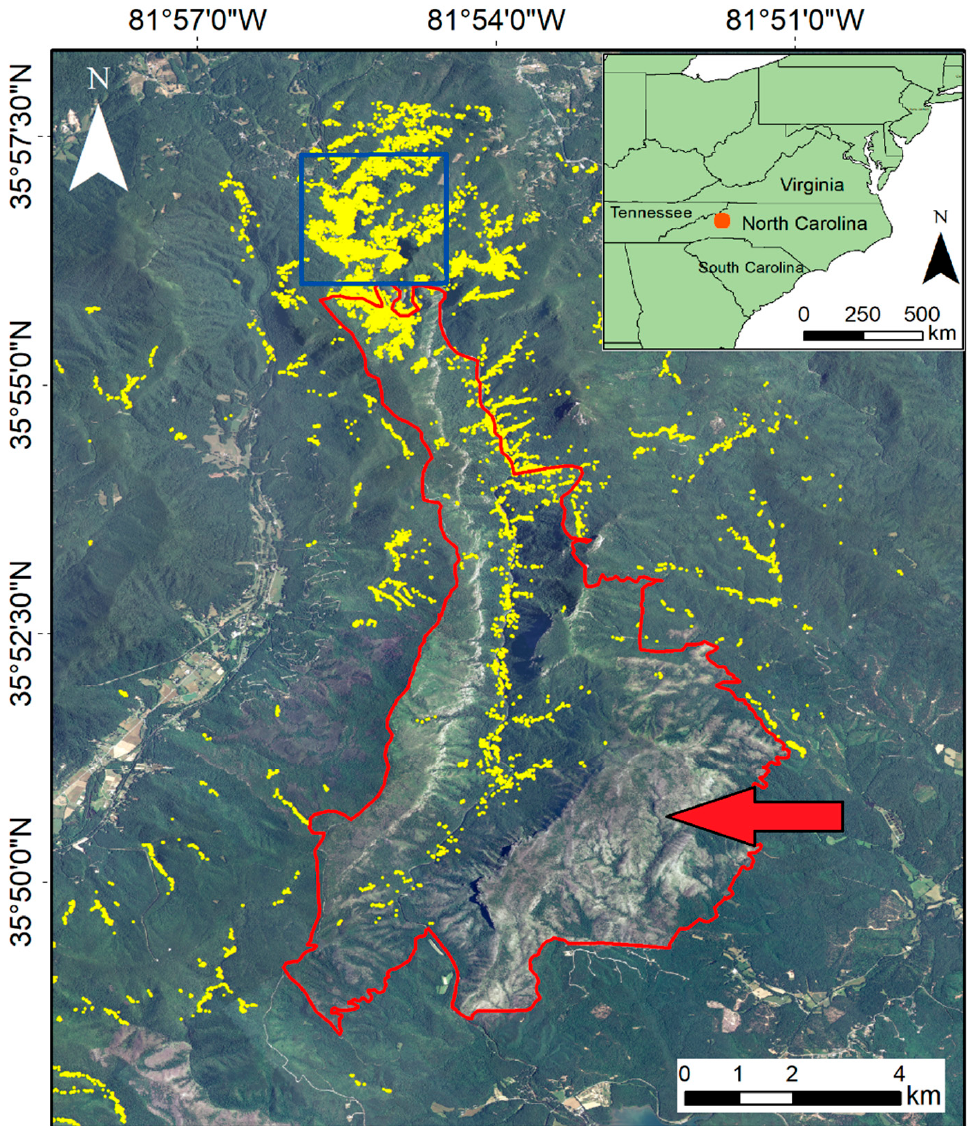
Figure 1. National Agriculture Imagery Program (NAIP) aerial image (5 July 2010) of the study site, Linville Gorge Wilderness Area, North Carolina, USA. Yellow points represent digitized dead hemlocks. The visible 2007 fire scars on this image, with light shades of grey and white, are pointed out with the red arrow. The blue square and the red boundary are sub-region 1 and 2, respectively, are selected for the further analysis.